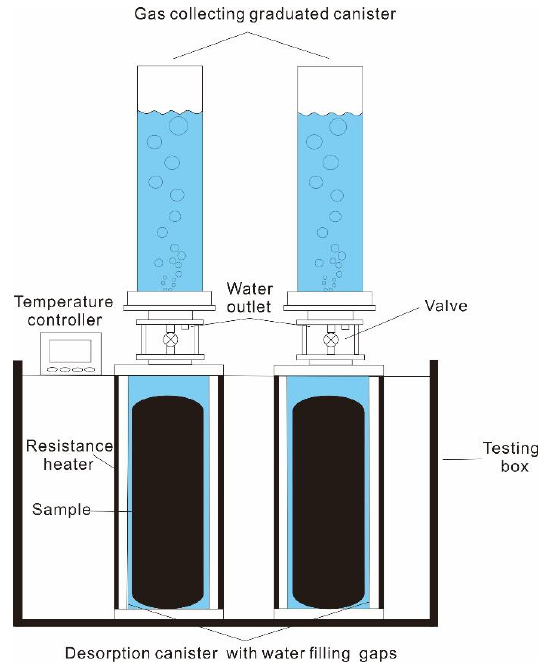
Figure 2. Schematic of GOF-I field canister degassing apparatus (modified after [48]).